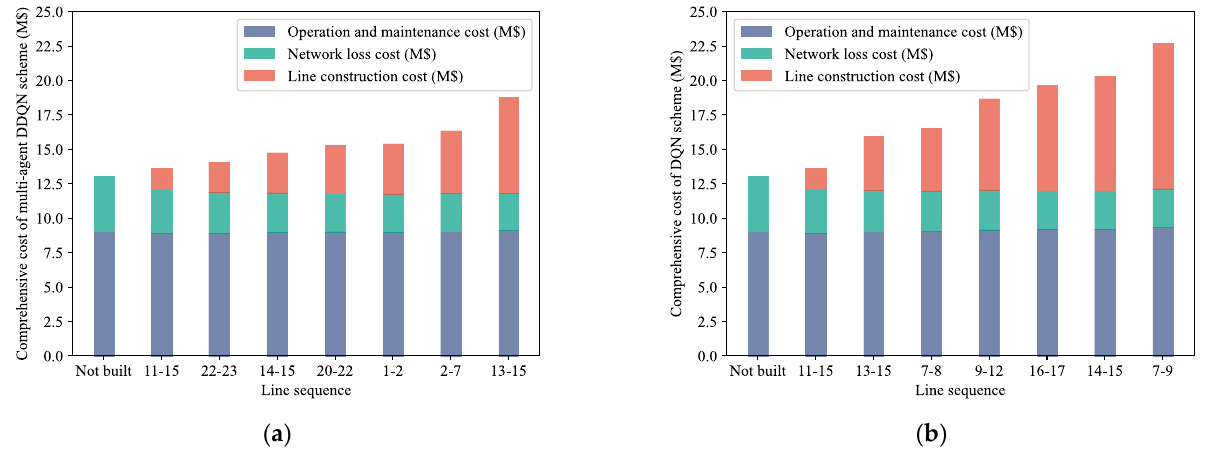
Figure 9. ( a ) Comprehensive cost changes of scheme obtained by multi-agent DDQN. ( b ) Comprehensive cost changes of scheme obtained by DQN.